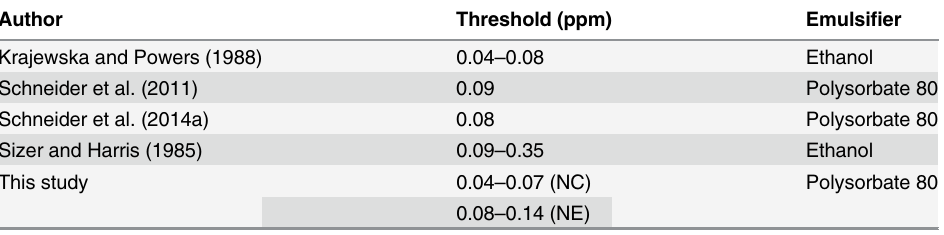
Table 3. Comparison of the thresholds of free capsaicin in literature with the present